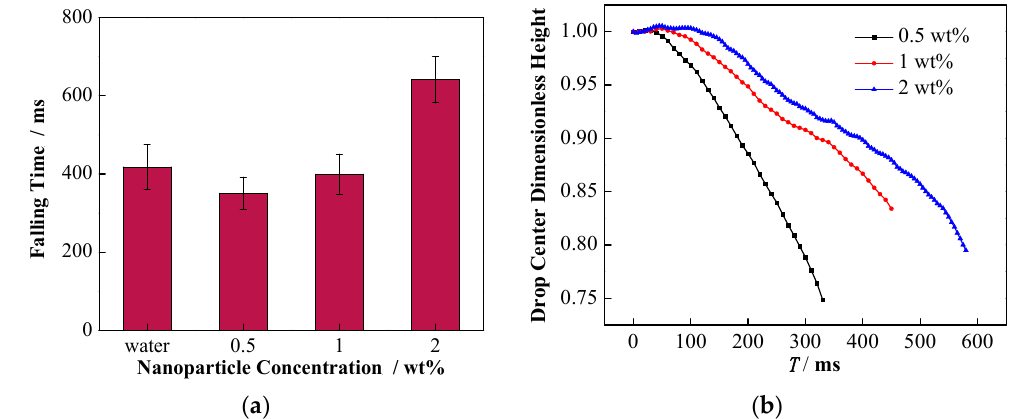
Figure 13. Effect of NP concentration on the migration of falling droplet. ( a ) The time of the droplet center falling to the interface under different particle concentrations; ( b ) effect of NP concentration on the dimensionless droplet center height.